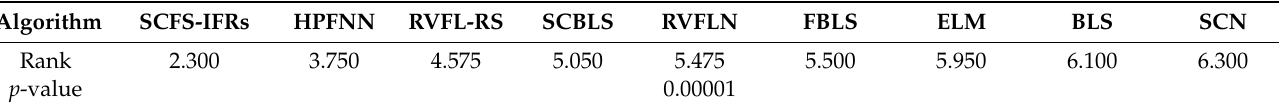
Table 5. Result of Friedman tests (significance level of 0.10).